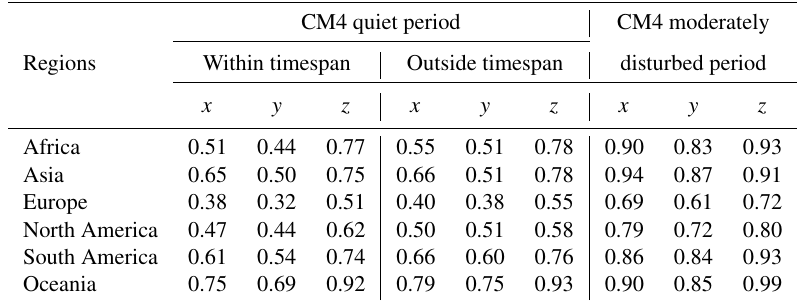
Table 1. Relative root mean square (rms) misfit between the CM4 and observatory data for quiet period (within and outside CM4 timespan) and for moderately disturbed period for each field component ( x , y , z